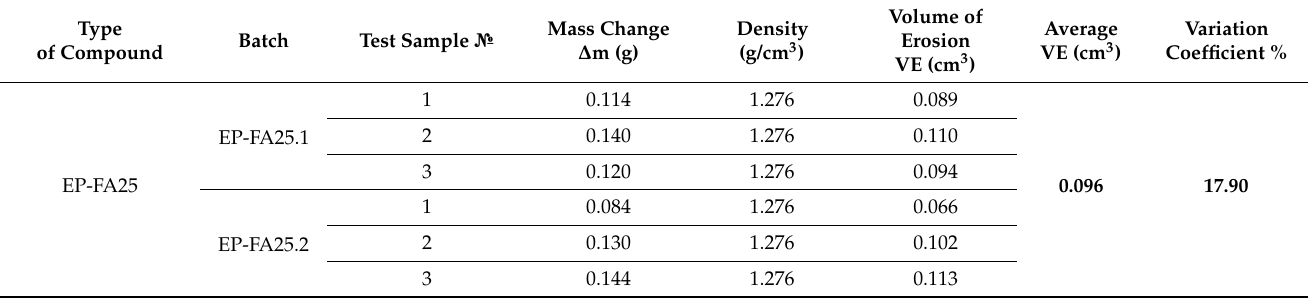
Table A7. Wear of filled epoxy binder (EP-FA25) at 23 ◦ C at an impingement angle of 90 ◦